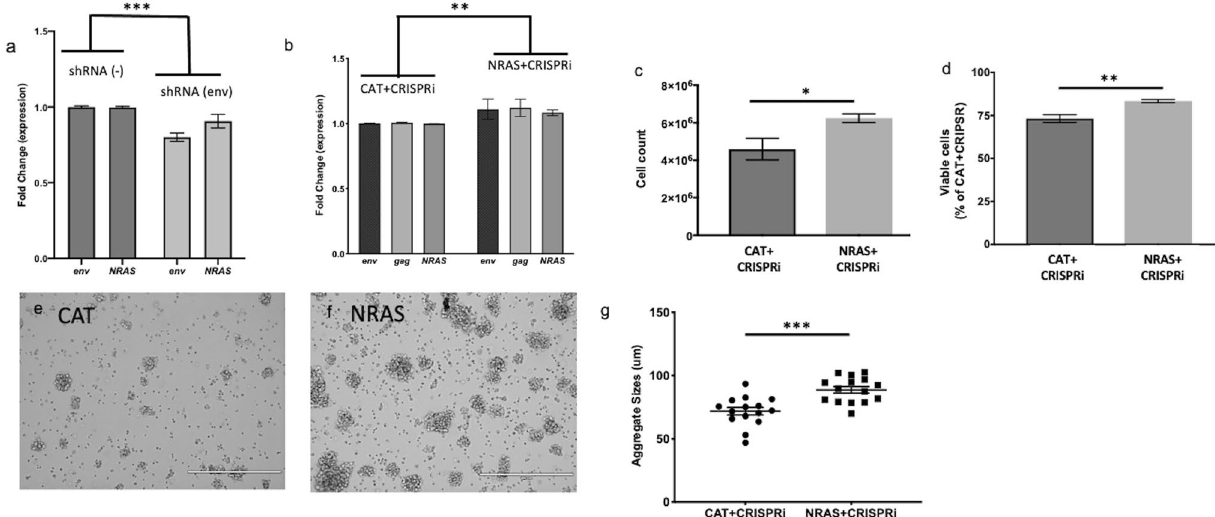
Figure 6. NRAS expression is downregulated post HML-2 downregulation, and its overexpression is sufficient to restore cellular proliferation to AT/RT cells. ( a ) Downregulation of HML-2 transcription with shRNA results in a decrease in NRAS expression. Transcription level of HML-2 env and NRAS measured with qPCR 48 h post transfection with shRNA targeting HML-2 env in CHLA 02. ( b – g ) Co-transfection with NRAS overexpression plasmid can overcome the effects of HML-2 downregulation. ( b ) Expression of env , gag , and NRAS transcripts 48 h post transfection in CHLA 04 cells with both CRISPRi + gRNA and NRAS plasmids. ( c ) Cell number in CHLA 04 AT/RT cells transfected with CRISPRi + gRNA and either a CAT plasmid or an NRAS construct and 5 days post-transfection. ( d ) Viable cell percentage 5 days post transfection with CRISPRi and either CAT or NRAS plasmids. Image of cells transfected with CRISPRi plus HML-2 gRNA and either CAT ( e ) or NRAS ( f ). ( g ) Quantification of cell aggregate size 5 days post-transfection with CRISPRi + gRNA and either CAT or NRAS plasmids. Graphs generated with Prism v9. [Error bars represent SEM. Statistics in Supplemental Table